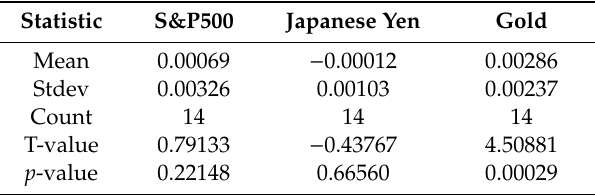
Table A10. The ($) h c-BA ’s HE − the ($) h c ’s HE.